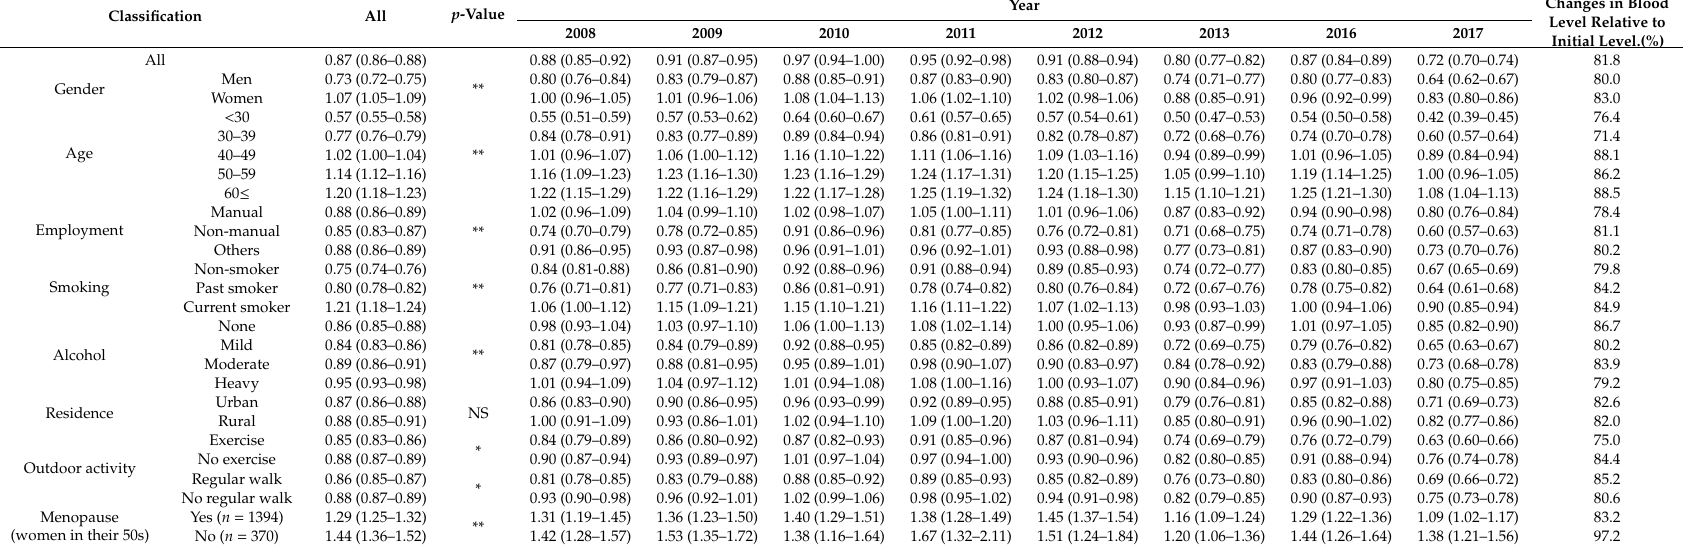
Table 3. Adjusted # geometric means and 95% CI of blood cadmium according to classification variables in representative Korean